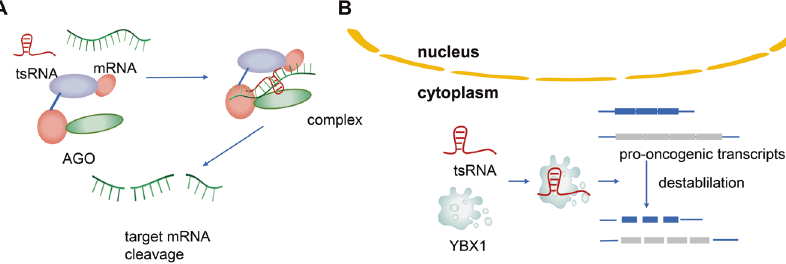
Fig. 2 The function of tsRNA on gene expression regulation. A tsRNA can be loaded into AGO family proteins in a miRNA-like manner to regulate the expression of target genes. B tsRNA binding to YBX-1, change the stability of oncogene mRNA, affect the expression of the